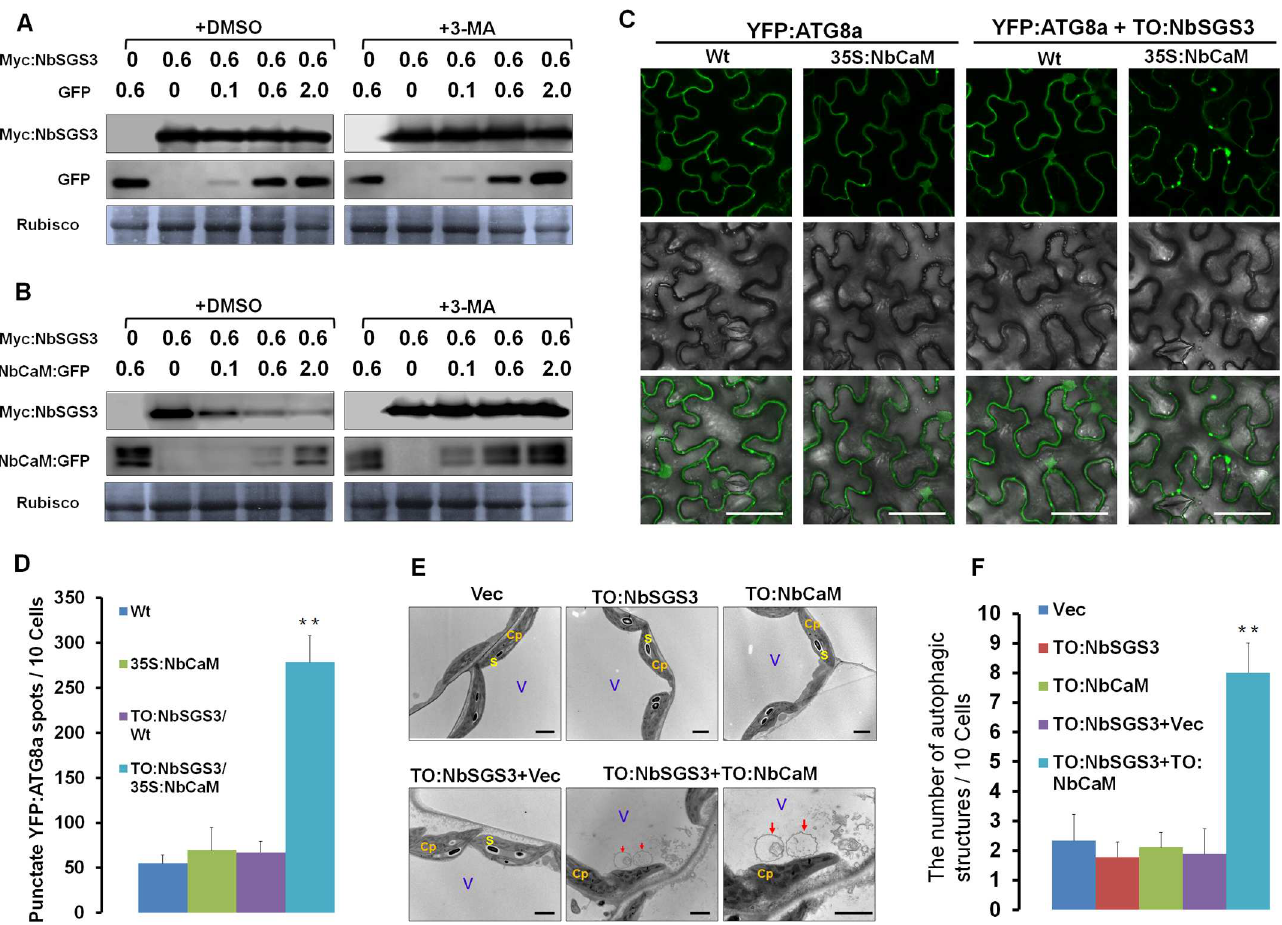
Fig 5. NbCaM-mediated degradation of NbSGS3is blocked by inhibitors of autophagy, and co-expression of NbCaM and NbSGS3induces autophagic activity. (A, B) Effect of the autophagyinhibitor3-MA on the accumulation of Myc:NbSGS3 whenco-expressedwith differentconcentrations of GFP (A) or NbCaM:GFP(B) at 2 dpi. Sampleswereanalyzedby Western blot usingMyc or GFP antibody. The OD 600 of Agrobacterium culture mixturescontaininga plasmidcapableof expressingMyc:NbSGS3 alone,or togetherwith GFP or NbCaM:GFP are indicated.DMSO or 3-MA (10 mM) was infiltrated into leaves32 h after beingagroinfiltrated with Myc:NbSGS3 alongwithGFP or NbCaM:GFP constructs. Sampleswereharvested from 16 h later. Coomassie brilliantbluestainingof Rubiscolargesubunitwas usedas a loadingcontrol.The assayswereperformedfrom at least three independent experiments, andonerepresentative result is shown. (C) Micrographs showingcellsexpressing YFP:NbATG8a alone,or together with NbSGS3 (TO:NbSGS3) on wildtype (Wt) or 35S:NbCaM transgenic(35S:NbCaM) N . benthamiana plants.Infiltrated N . benthamiana leaveswere examinedat 48 hpi. Bars represent50 μ m. (D) The averagenumberof punctateYFP fluorescent structures per 10 cellsshownin (C). Independent infiltrationexperiments wereperformedthree times and10 cellsexaminedin eachexperiment to givea total of thirty cells. Valuesrepresentthe mean ± standard deviation (SD). Doubleasterisks indicatea highlysignificantdifference(p < 0.01)betweenVec andNbSGS3+ NbCaM-infiltratedleaves (Student’s t test). (E) Representative TEM imagesof N . benthamiana leaveswith the transientoverexpressionof empty vector (Vec), NbSGS3(TO: NbSGS3), NbCaM(TO:NbCaM), TO:NbSGS3+Vec or TO:NbSGS3+TO:NbCaM.Obviousautophagic structures(red arrows)wereobservedin TO: NbSGS3+To:NbCaM infiltratedleavesin the centralvacuoleof mesophyllcellsat 2 dpi. Cp: chloroplast, S: starch, V: vacuole.Bars = 2 μ m.( F )The number of typical double-membraneautophagosomein leavesinfiltratedwith TO:NbSGS3, TO:NbCaM, TO:NbSGS3+Vecor TO:NbSGS3+TO:NbCaM, whichwas normalizedto thosefoundin leavesinfiltratedwith emptyvector. Infiltration andTEM observation experiments wererepeatedtwiceand approximately60 cellsin total wereusedto quantifyautophagic structuresin eachtreatment.Valuesrepresentthe meannumberof autophagosomes ± standard deviation (SD). Student’s t test was performedto comparedifferencesbetween Vec andNbSGS3,NbCaM,NbSGS3+Vec or NbSGS3 +NbCaM-infiltrated leavesanddoubleasterisks indicatea highlysignificant difference(p < 0.01).